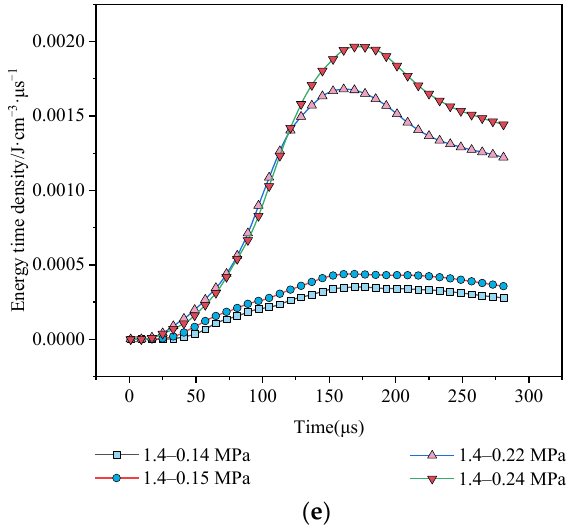
Figure 5. The time-energy time density curves: ( a ) aspect ratio is 0.6; ( b ) aspect ratio is 0.8; ( c ) aspect ratio is 1.0; ( d ) aspect ratio is 1.2; ( e ) aspect ratio is 1.4. The equilibrium point and peak point curves show the sensitivity of w td to strain rate. Table 2. The energy dissipation results of the samples at different strain rates.